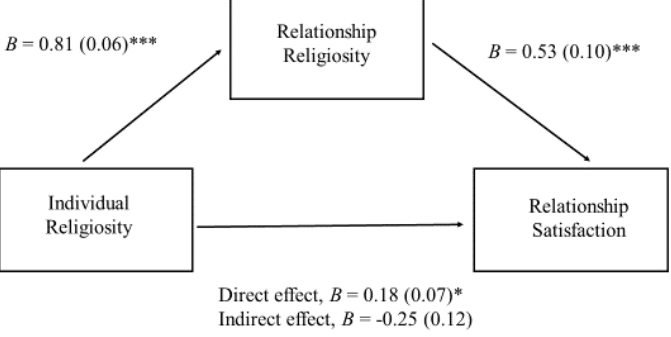
Figure 1. Mediation model for relationship religiosity and relationship satisfaction.